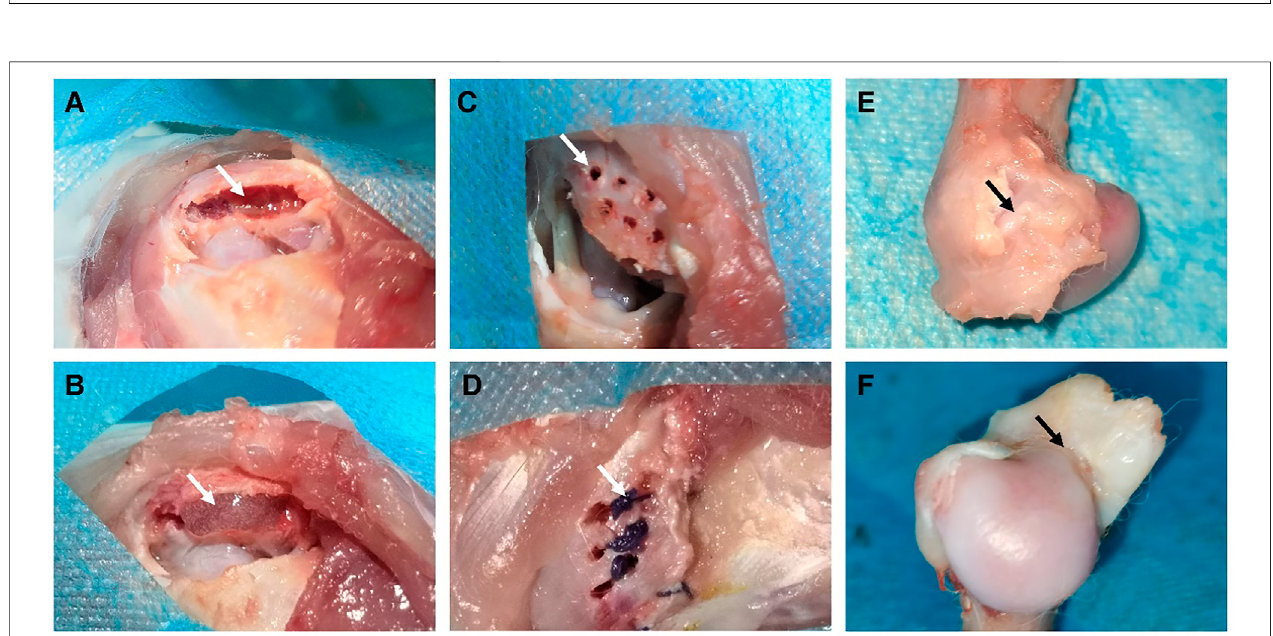
FIGURE 4 | (A) Bone groove (8 mm in length, 2 mm in width, and 2 mm in depth) was made at the tendon stop point. (B) The hydrogels were implanted into the bone groove. (C) Holesforasuture passweredrilledwithadiameterof0.8 mmfrom theoutsideofthehumerus tothebonegroove. (D) Absorbablesuture wasused to fi x the broken subspinatus muscle above the bone groove. (E) The bursal surface of rotator cuff after the repair of CS-KGN/FGF-TBA for 8 weeks. (F) The articular surface of rotator cuff after the repair of CS-KGN/FGF-TBA for 8 weeks.